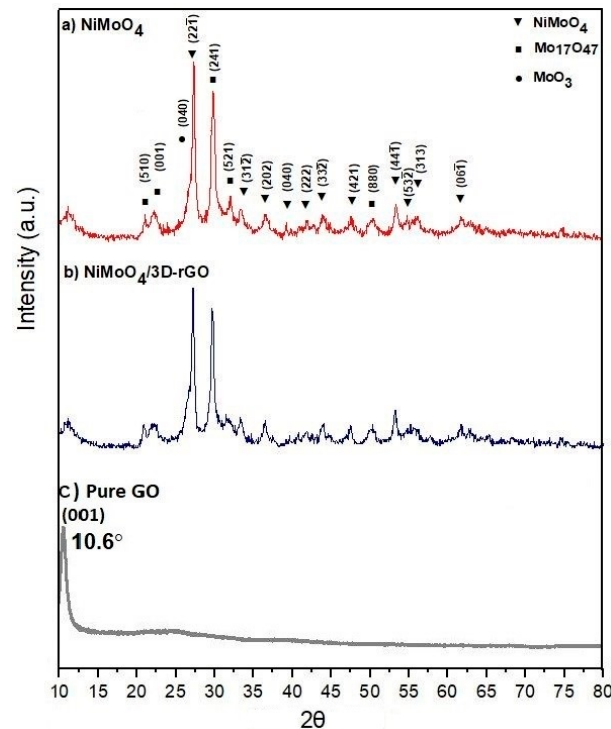
Figure 2. X-ray diffraction (XRD) patterns of the ( a ) NiMoO 4 NPs, ( b ) NiMoO 4 /3D-rGO nanocomposite after heating at 350 °C, and ( c ) pristine GO.